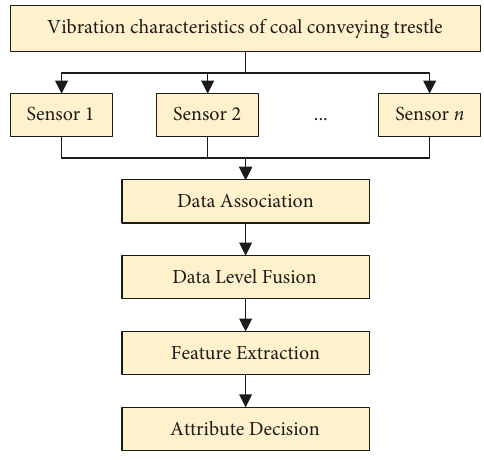
Figure 2: Data level